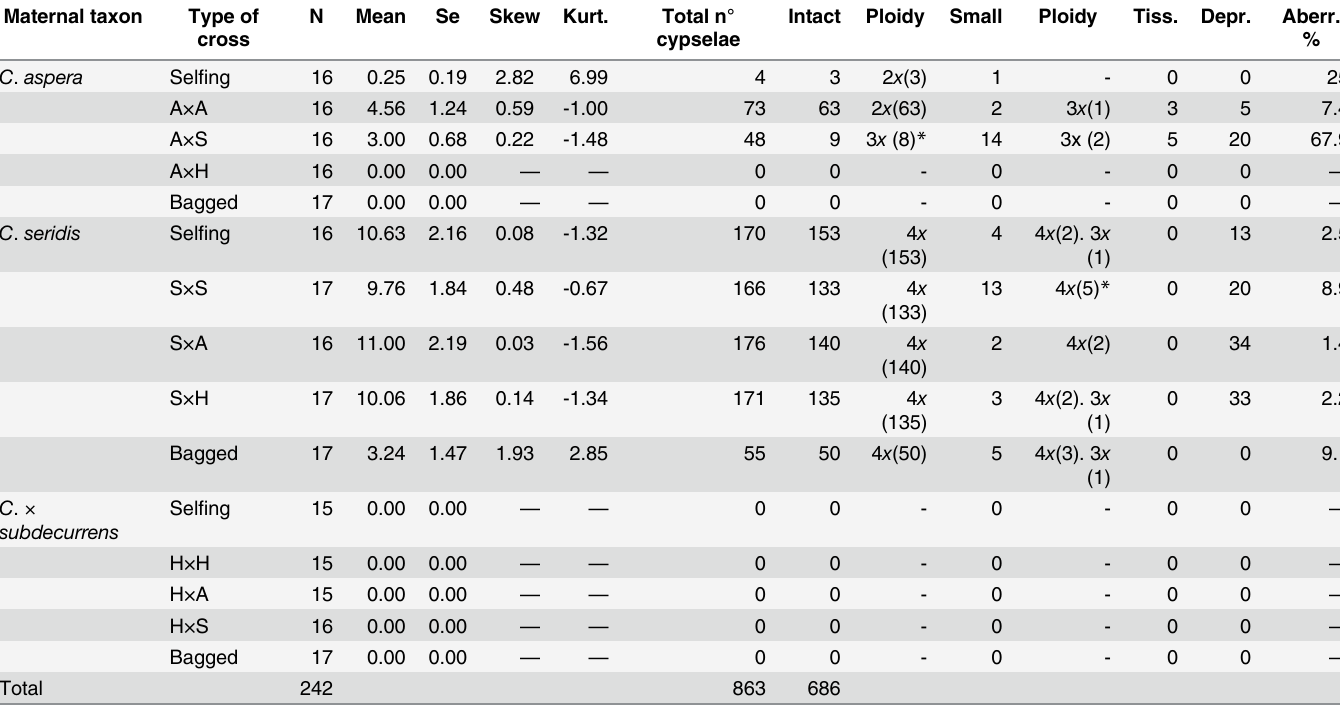
Table 1. Number of cypselae, category and ploidy level obtained for each pollination treatment and taxon. Maternal taxon Type of cross